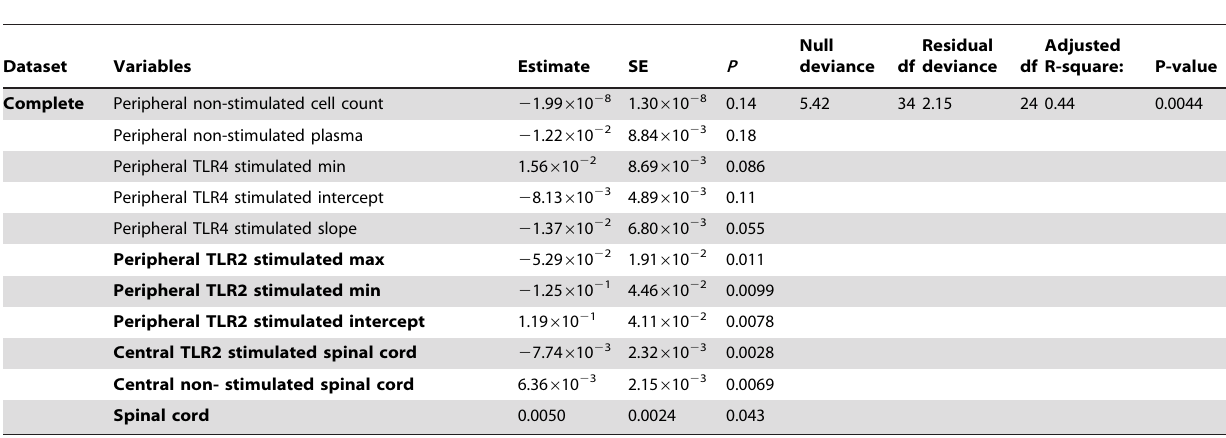
Table 5. Best-fit logistic regression model results for the prediction of the pain severity in rats post CCI in all experimental groups.